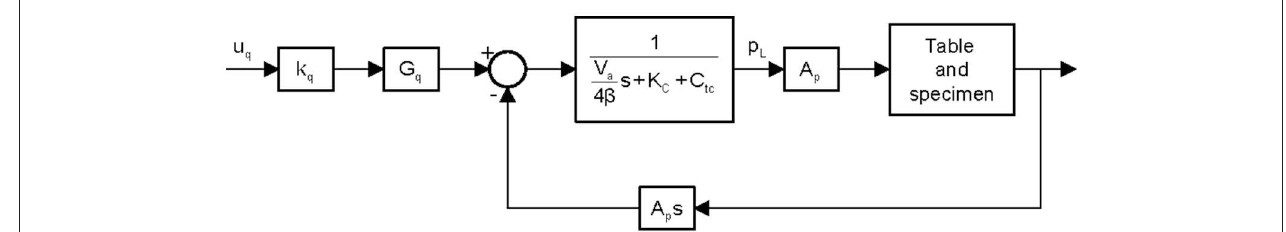
FIGURE 2 | Block diagram of hydraulic systems.